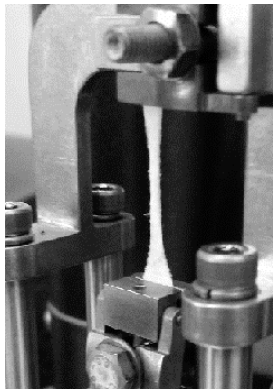
Figure 9. The nonwoven sample temporary shape in the clamps DMA apparatus.